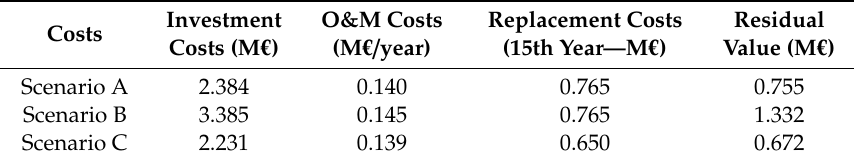
Table 5. Project costs (re-evaluated in 2019 € ). All items are adjusted with Conversion Factors. Replacement costs include electro-mechanic devices in the TT plant in all scenarios and pumps to boost reclaimed water to irrigation districts in scenarios A and B.